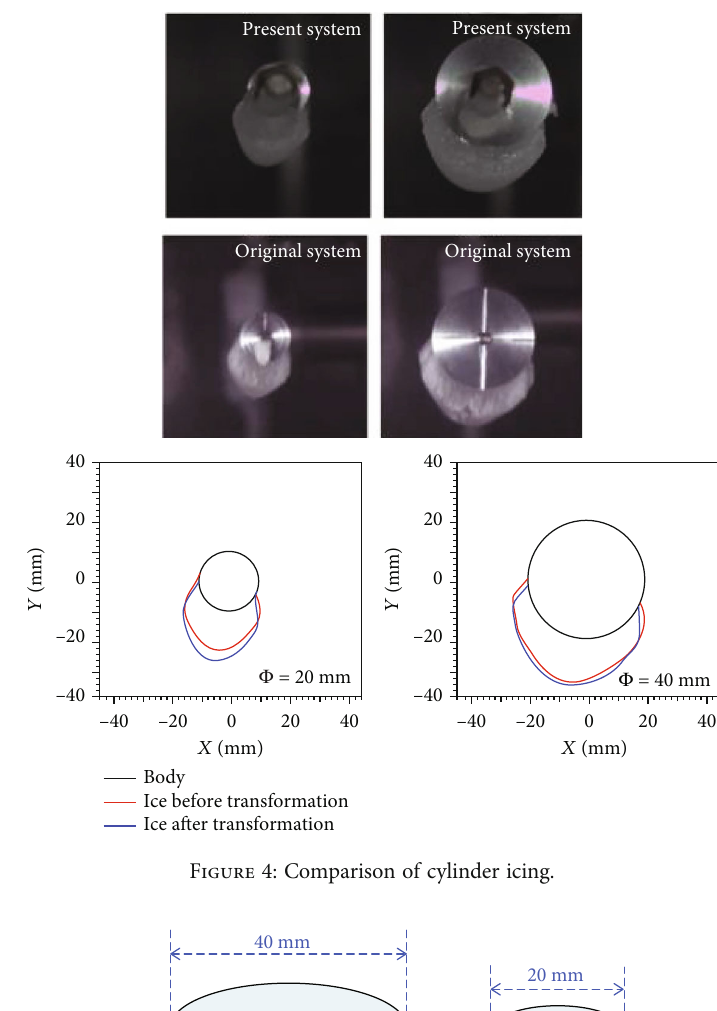
Figure 4: Comparison of cylinder icing.